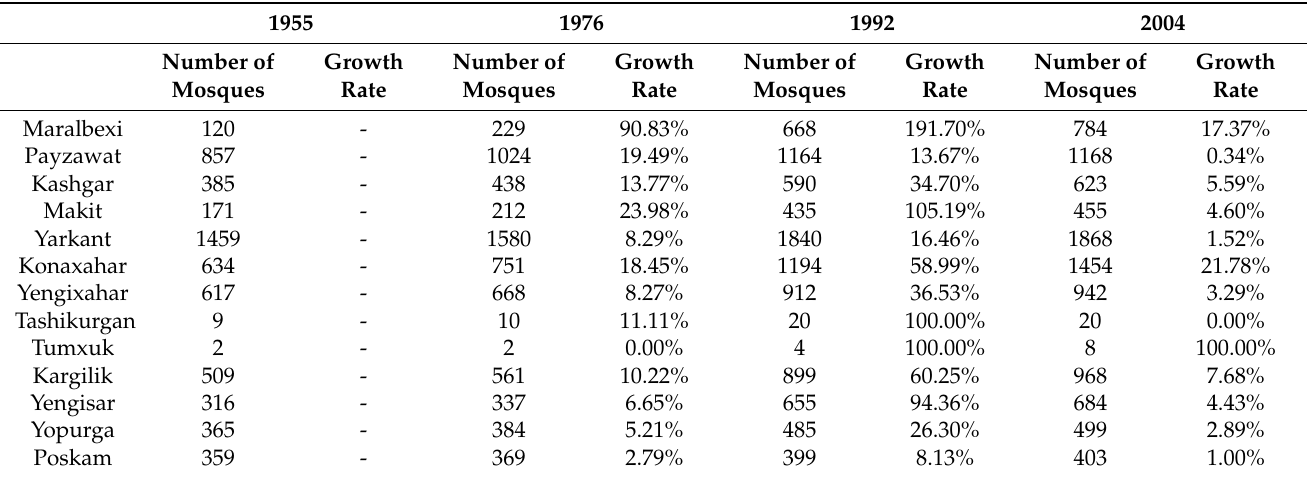
Table 1. Changes in the number of mosques by administrative counties in the Kashgar